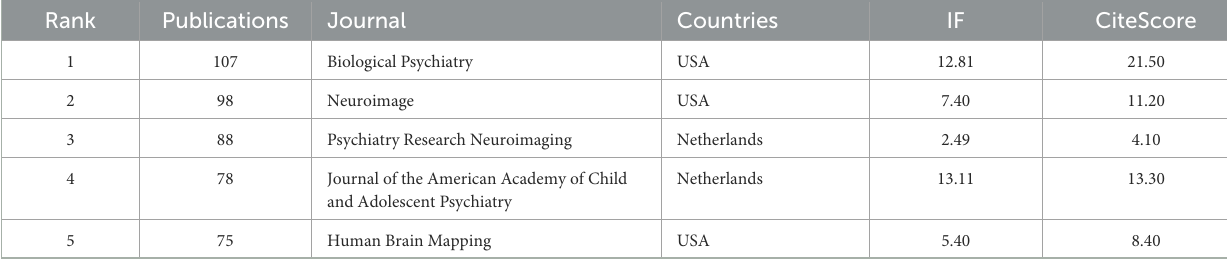
TABLE 5 Top five most productive journals related to ADHD neuroimaging.